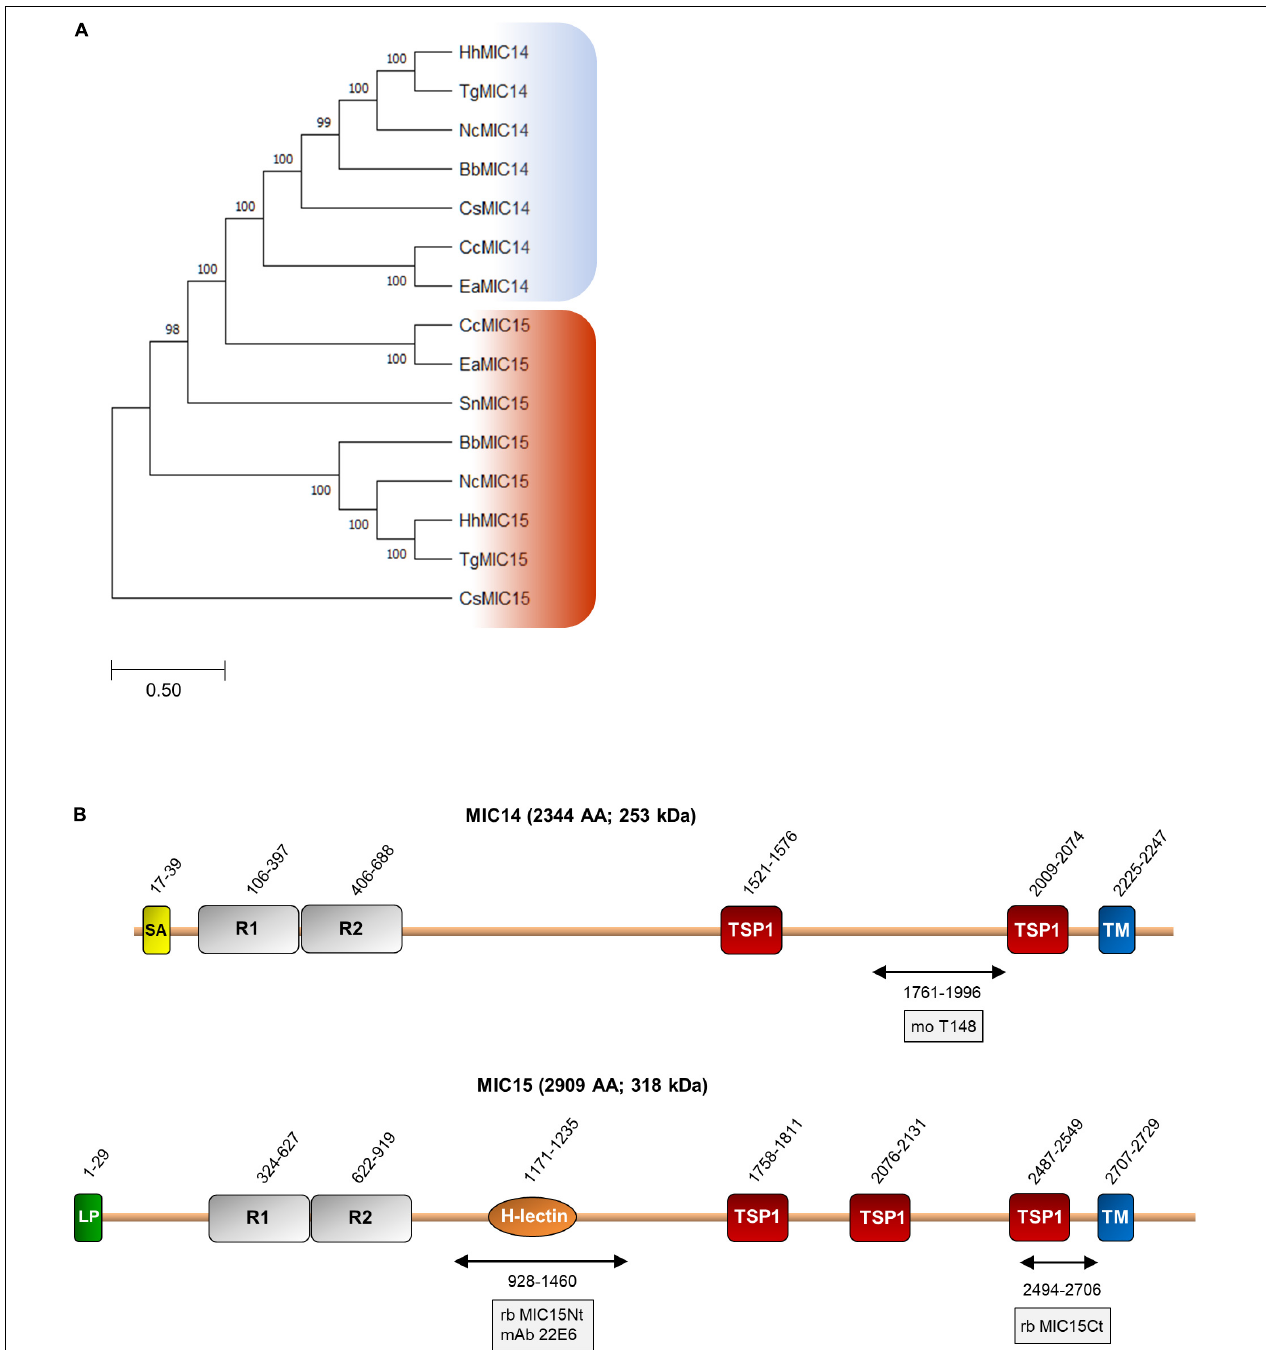
FIGURE 2 | Phylogenetic analysis and domain organization of MIC14 and MIC15. (A) Unrooted maximum likelihood phylogenetic tree of MIC14 and MIC15 proteins in Apicomplexa. Bootstrap values for 1,000 trials are shown. The amino acid alignment used to generate the tree is shown in Supplementary Figure 8 . Amino acid sequences used to generate the phylogenetic tree are identified by the following accession numbers: Toxoplasma gondii , MIC14 (AY089992), MIC15 (DQ459408); Besnoitia besnoiti , MIC14 (XP_029221473), MIC15 (XP_029222264); Cyclospora cayetanensis , MIC14 (XP_026191791), MIC15 (XP_026191793); Cystoisospora suis , MIC14 (PHJ15367), MIC15, (PHJ22147); Eimeria acervulina , MIC14 (XP_013251268), MIC15 (XP_013251270); Hammondia hammondi , MIC14, (HHA_218310), MIC15, (HHA_247195); Neospora caninum , MIC14 (CEL70510), MIC15 (CEL70693); Sarcocystis neurona , MIC15 (SN3_00200915). (B) Schematic representation of T. gondii MIC14 and MIC15 full-length proteins. The numbers identify the amino acid positions of major domains or elements or the extremes of the protein regions (double arrows) expressed in bacteria for antibody production. The names of the antibodies are boxed. The numbers of amino acids and the predicted molecular mass of the full-length proteins are shown in brackets. H-lectin, H-lectin domain; TSP1, thrombospondin type 1 domain; LP, leader peptide; R1 and R2, N-terminal repeats; SA, signal-anchor sequence; TM, transmembrane region.